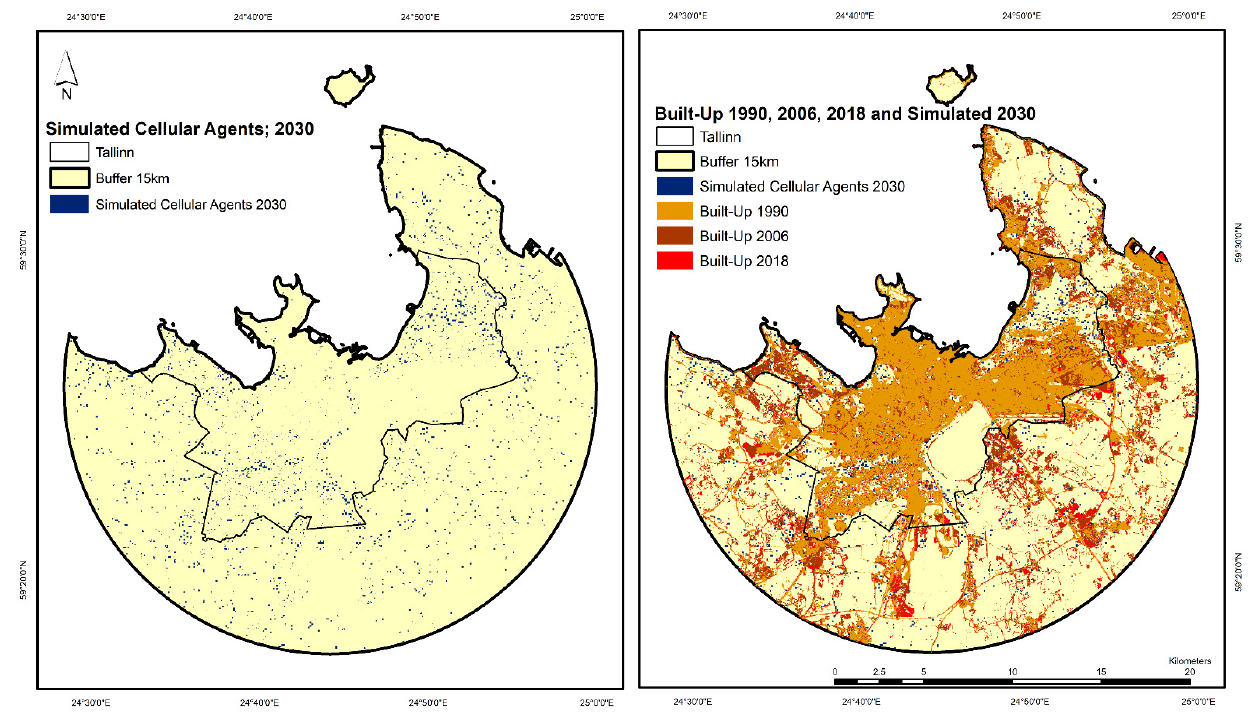
Figure 7. Simulated map of urban expansion in Figure 7 . Simulated map of urban expansion in 2030.